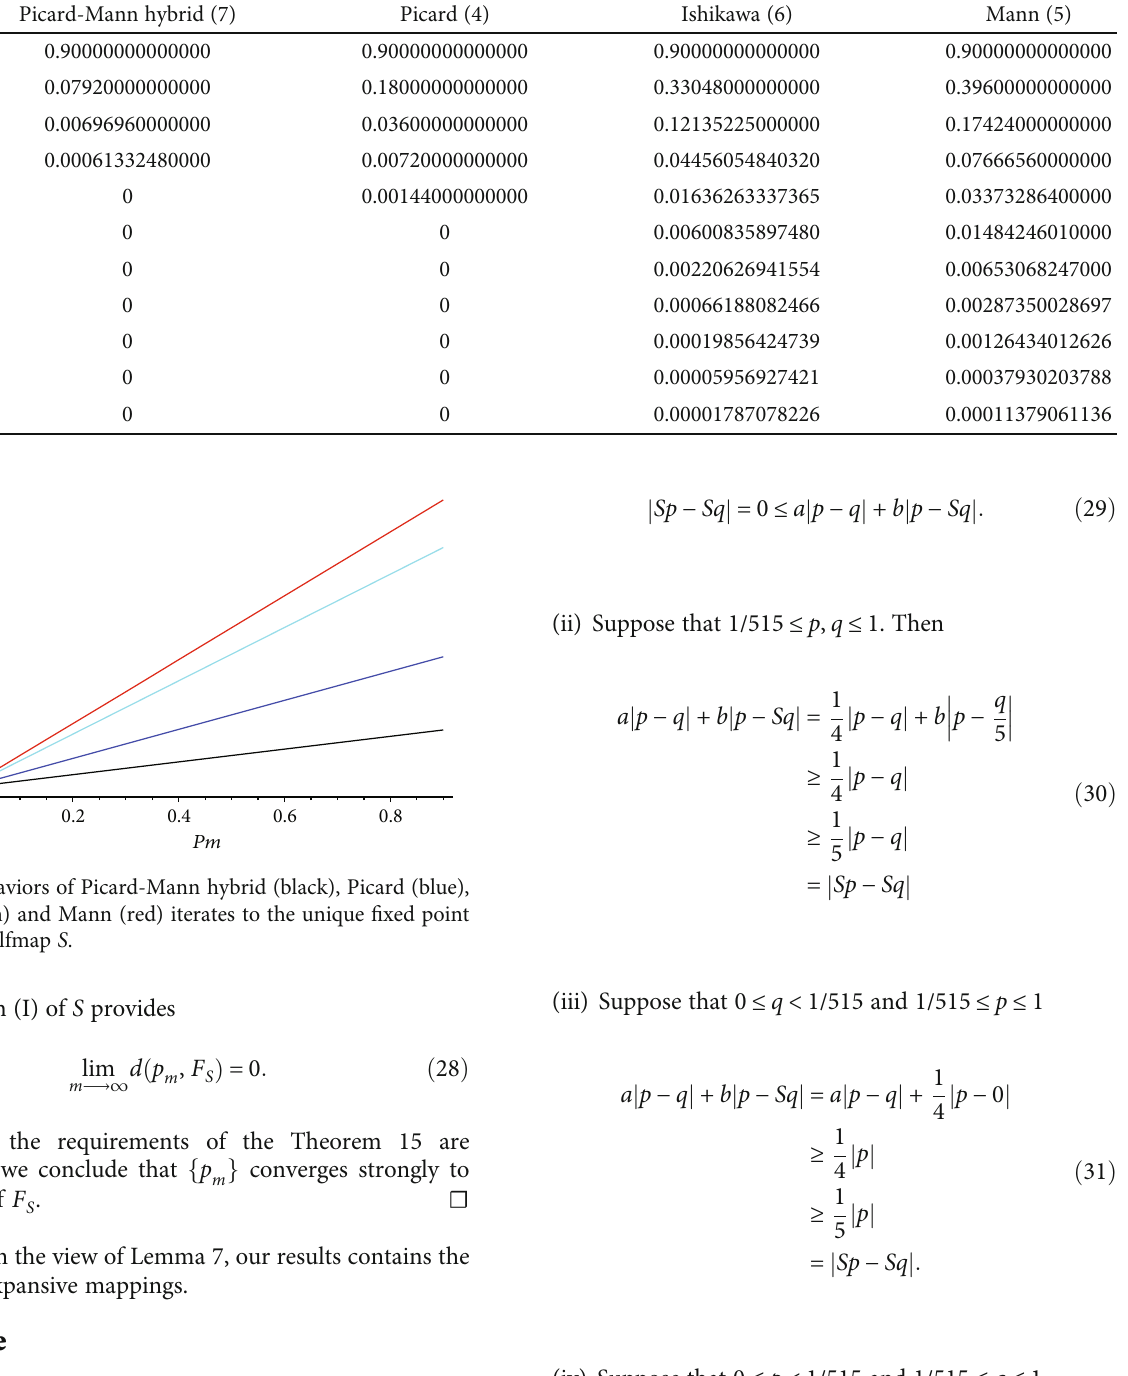
= 0 of S in Example 19. 0